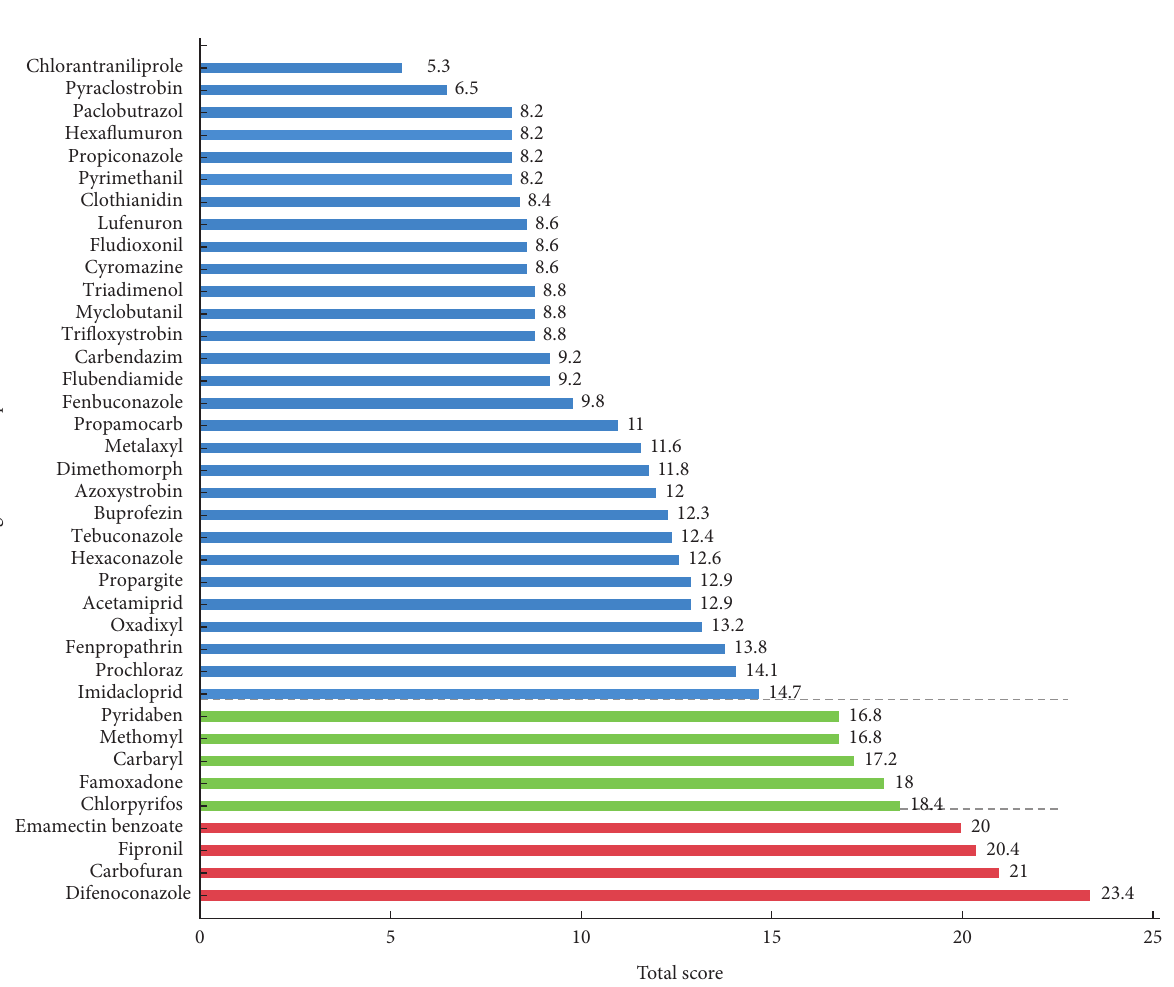
Figure 3: Risk ranking score for 38 pesticide residues in D. officinale